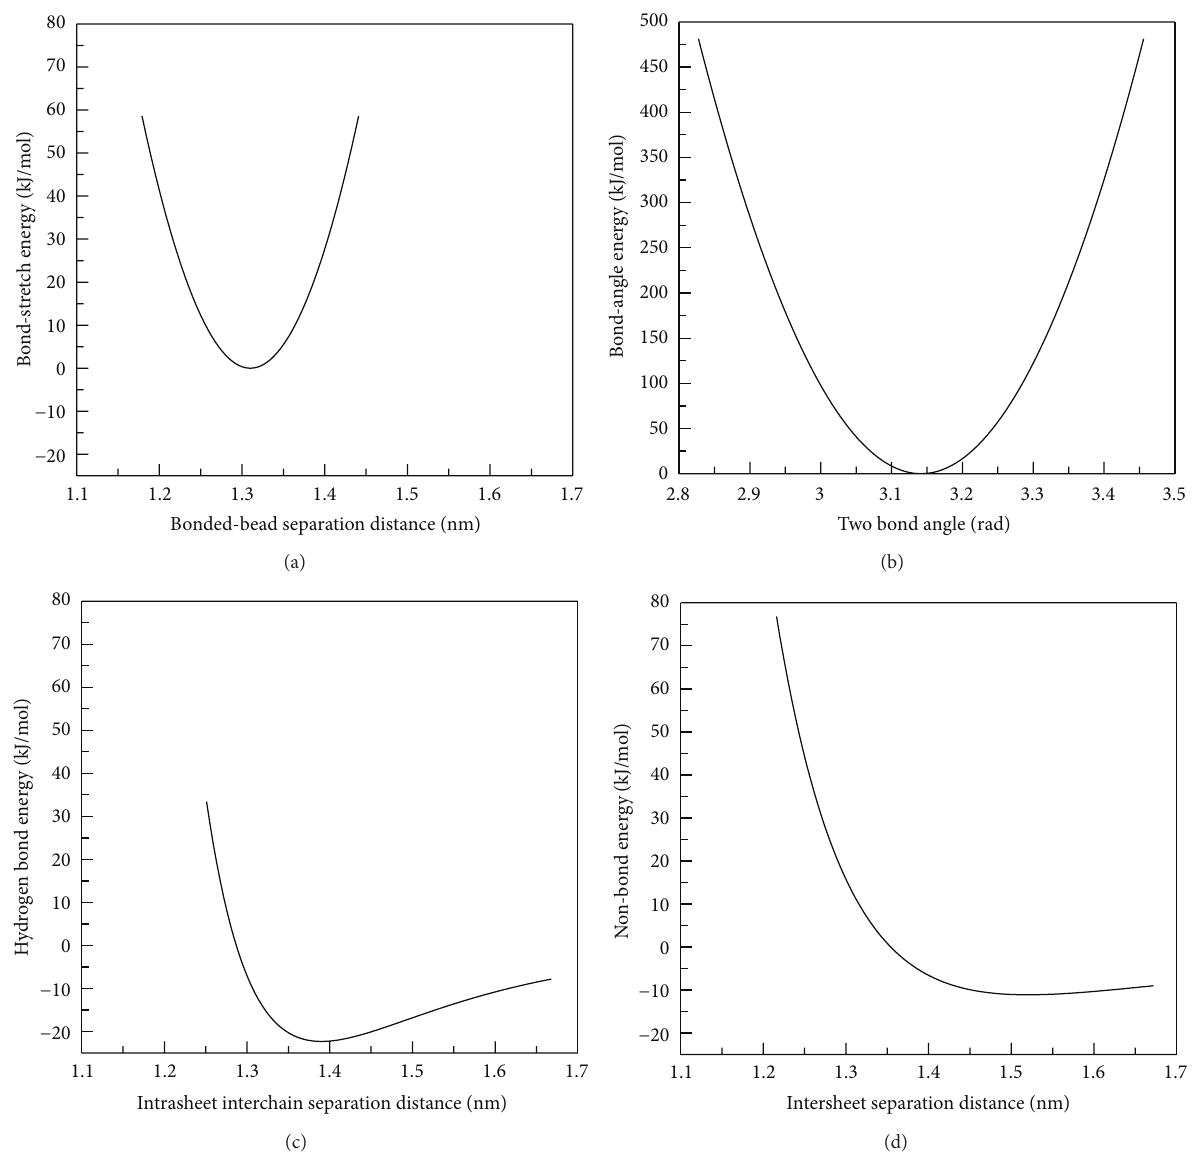
Figure5:Coarse-grainedPPTAforce-fieldfunctionsusedinthepresentwork:(a)bond-stretchterm;(b)two-bond-angleterm;(c)hydrogen- bond term; and (d) non-bond term.